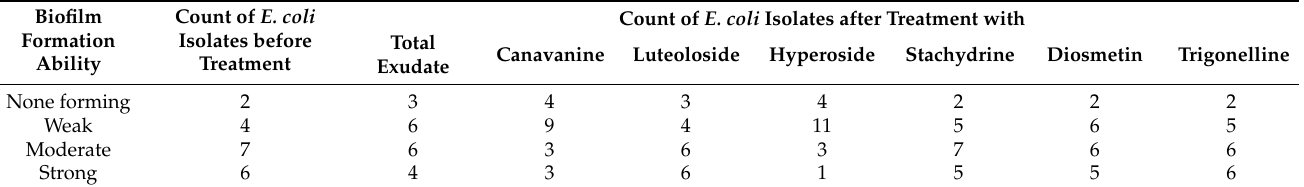
Table 4. Impact of the tested compounds on the biofilm of E. coli